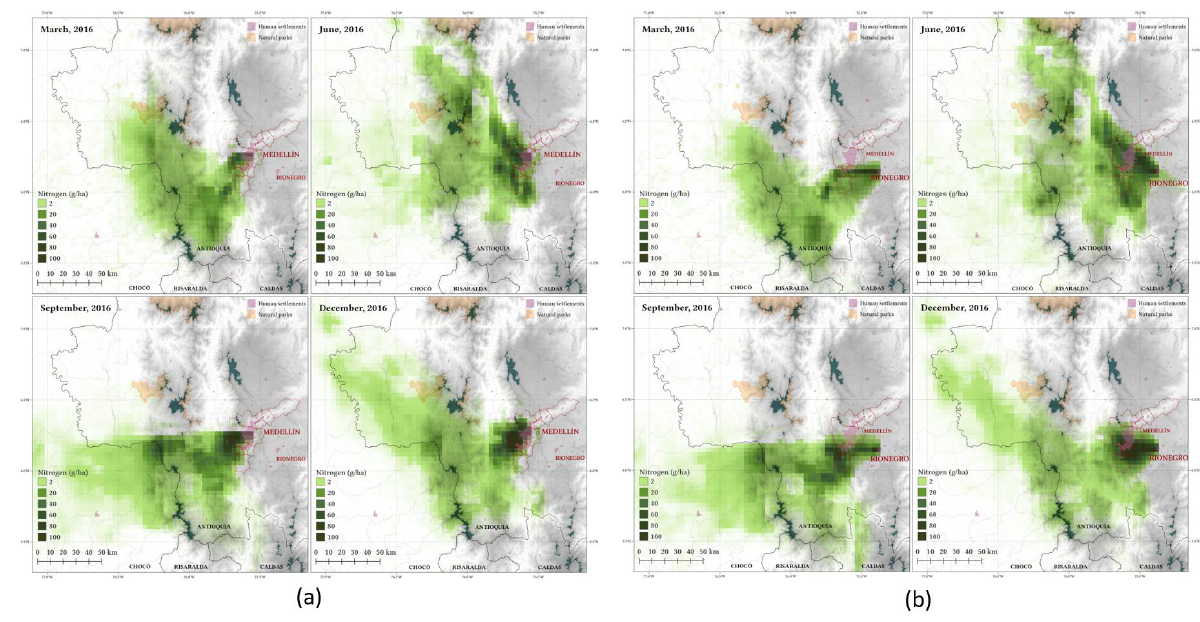
Figure 1. The figure shows two patterns for the hypothetical simulation for regional atmospheric pollutant transport. The panels in the image represent simulation results using the LOTOS-EUROS CTM for Medellín ( a ) and Rionegro ( b ) with a point source of nitrogen oxides equivalent to the emitted by the city in one day (1000 kg of nitrogen oxides/hour). These releases were over the background concentration (The background simulation was removed, which makes that the NO 2 was liberated from a specific point) during the hours of 06:00–20:00 on the third day of the simulation. The deposition was monitored from day 3 through day 9 (days 1 and 2 were used as model ramp-up